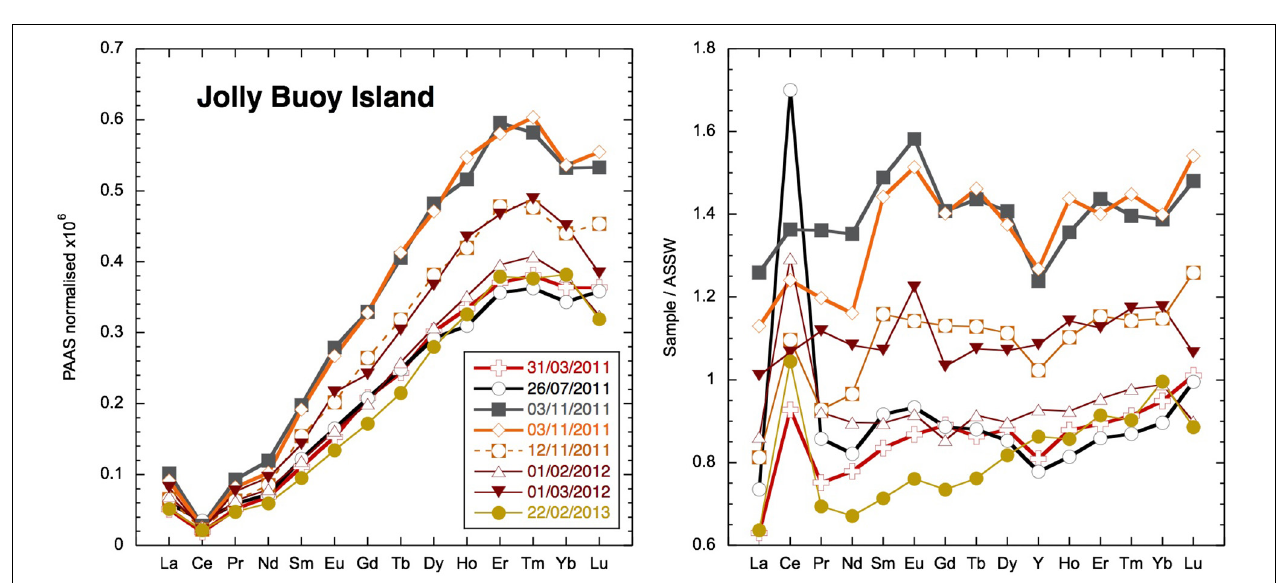
FIGURE 6 | Shale (PAAS; Nance and Taylor, 1976) normalized rare earth element (REE) patterns for Smith and Avis Island time series. The Nd isotope composition measured for samples from March and November are marked with the same color as the associated REE pattern.